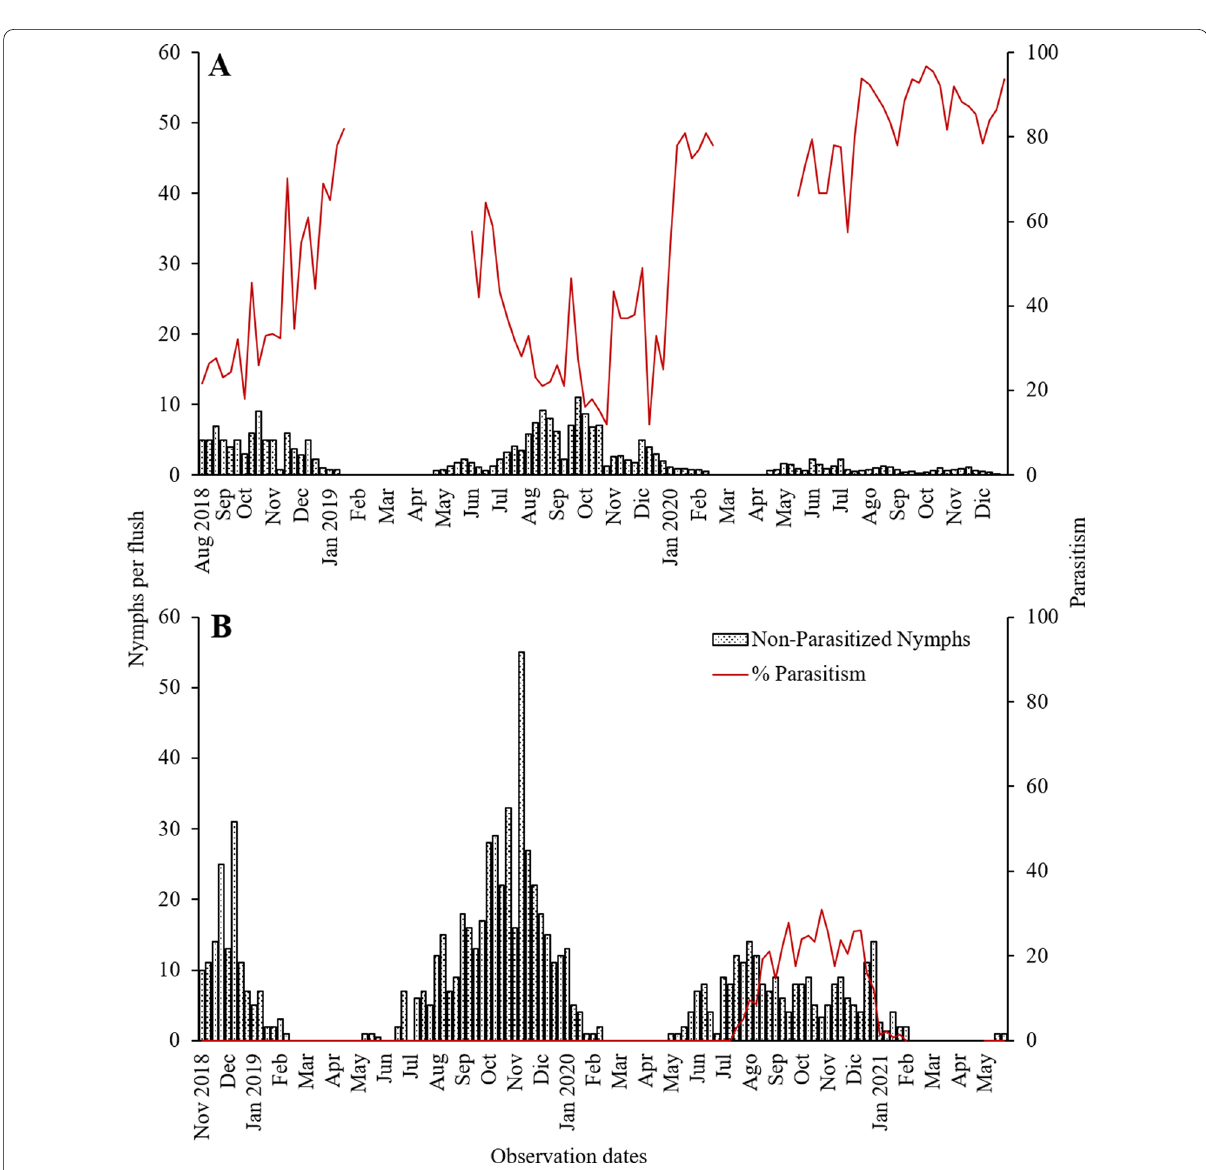
Fig. 2 Population fluctuation of non-parasitized nymphs of Diaphorina citri and the percentage of parasitism by Tamarixia radiata . a Murraya paniculata , b Citrus x aurantiifolia . Period August 2018–May